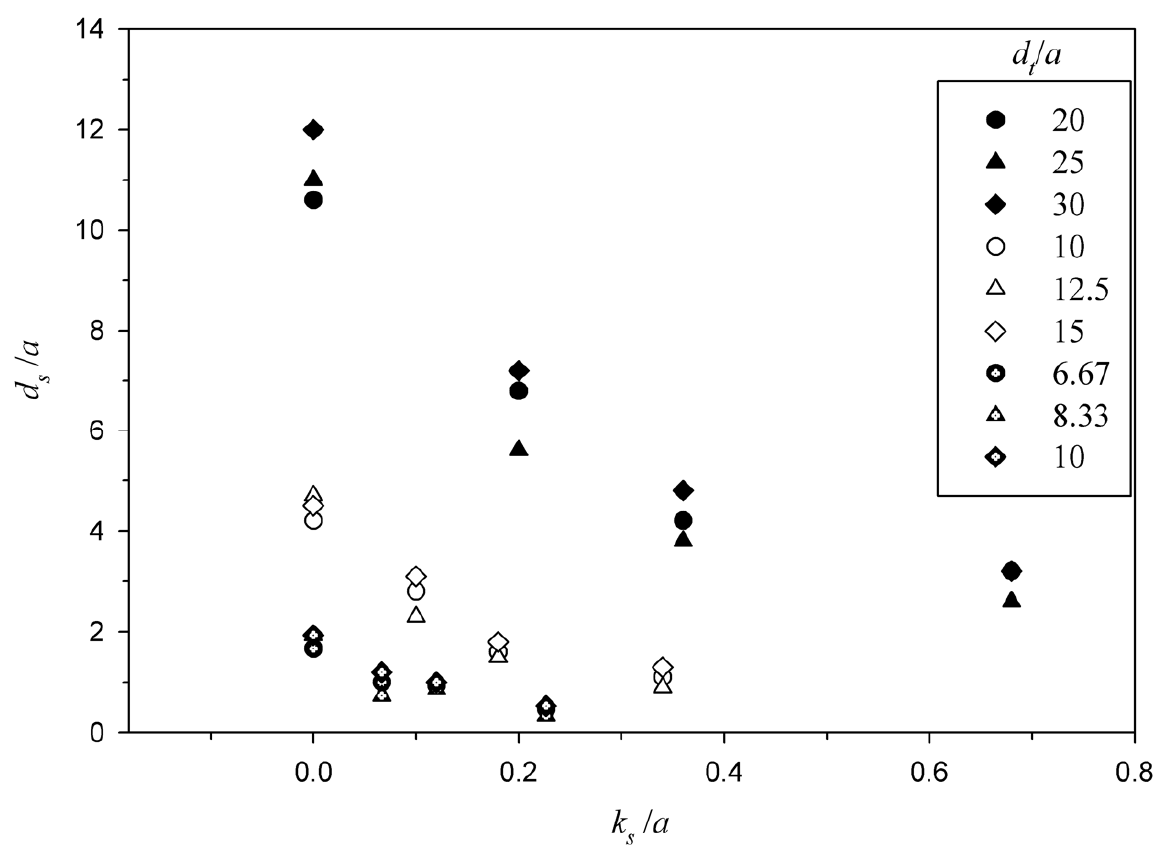
Figure 4. d s / a variation with k s / a for various a and d t.